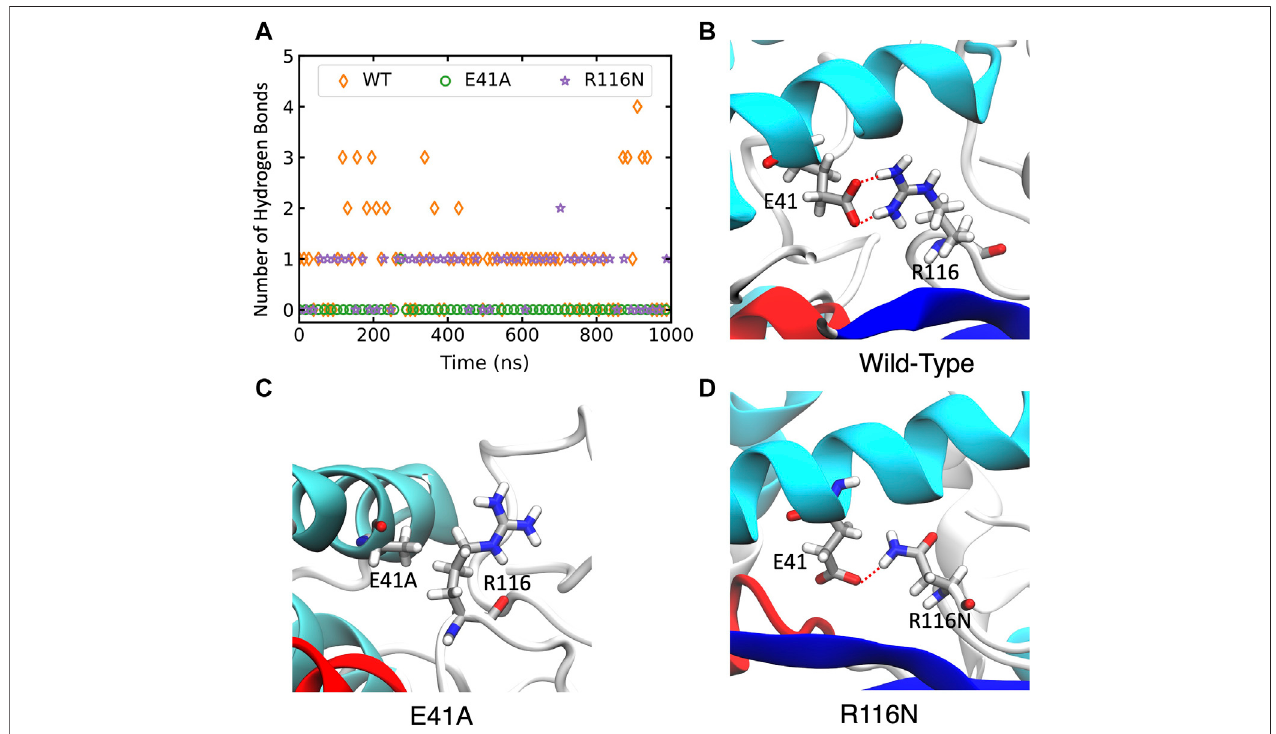
FIGURE 5 | The changes of hydrogen bonds between residues 41 and 116 in the wild-type (WT) ABHD5 and its mutants. (A) The number of hydrogen bonds between residues 41 and 116 over the course of 1-µs GaMD trajectories. The changes in hydrogen bonds of the WT, E41A, and R116N systems are indicated by orange, green, and purple, respectively. (B – D) The GaMD snapshots of the WT, E41A, and R116N system.